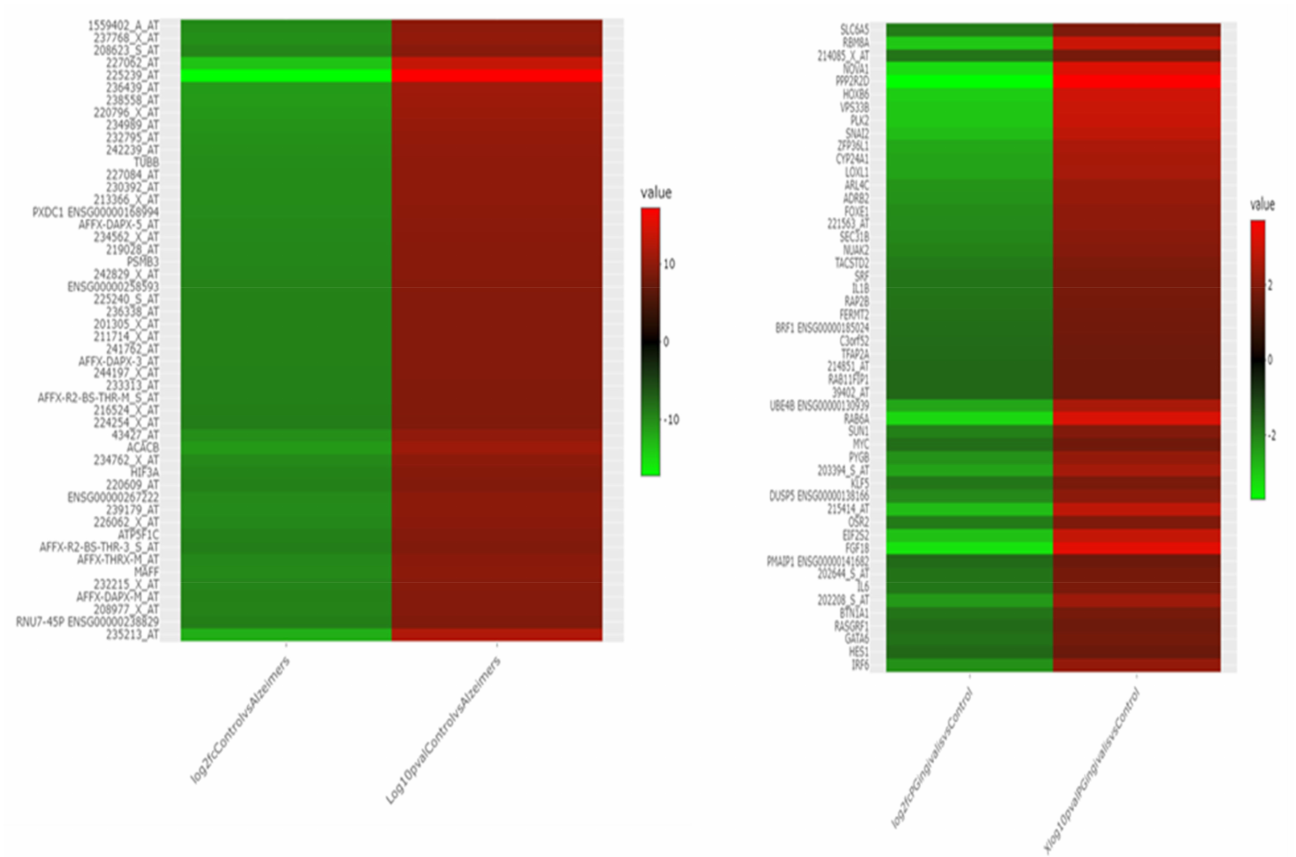
Figure 2. Heat maps of the differentially expressed genes (DEGs) according to their genes and expressions. The gene symbols are shown on the left side of the heat maps.